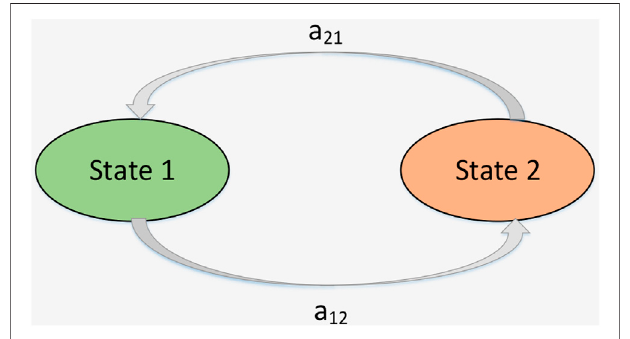
FIGURE 4 | A Markov chain with two states.